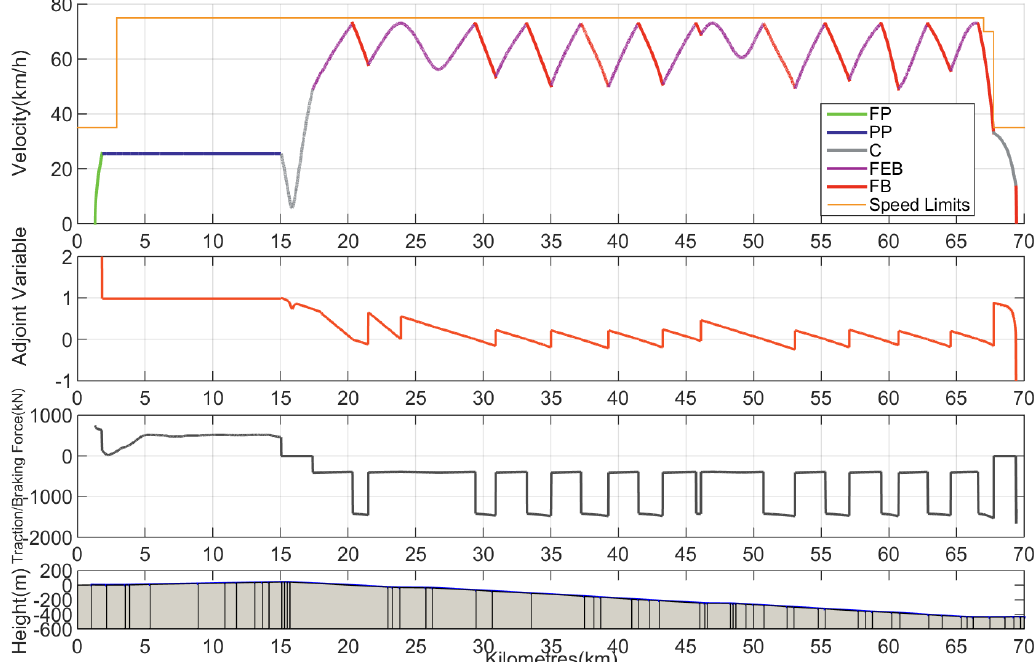
Figure 16. Optimal speed profile of train energy-efficient operation considering LDSD section (trip time: 95 min).